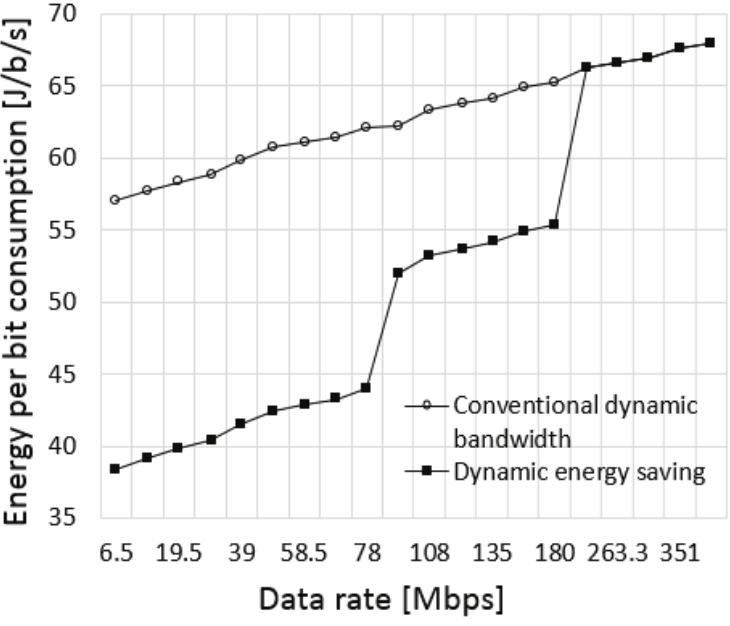
Figure 8. Energy consumption over data rates when using the link adaptation